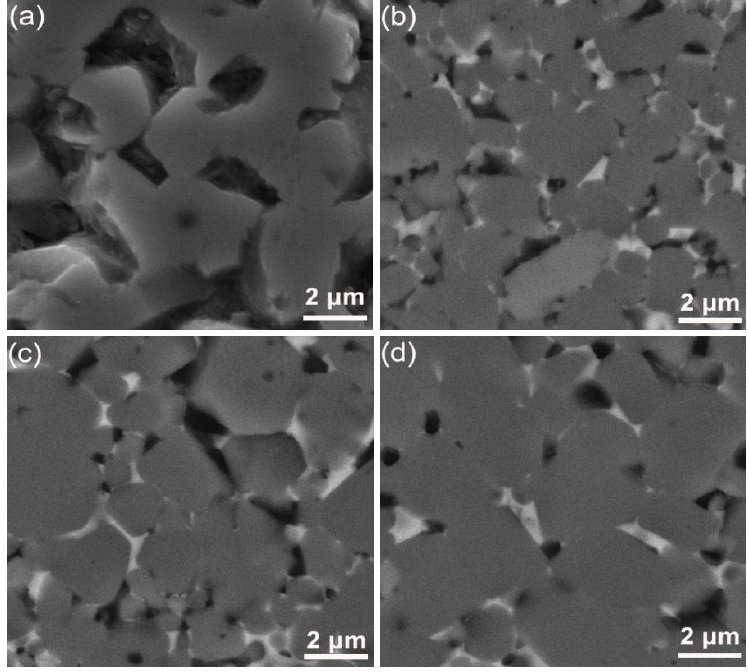
Figure 8. Comparison of SEM (scanning electronic microscope) micrographs of ( a ) the pure TiB 2 sintered at 1800 °C and the TiB 2 –5 wt% (Fe–Ni–Ti–Al) sintered at different temperatures of ( b ) 1300 °C; ( c ) 1400 °C and ( d ) 1500